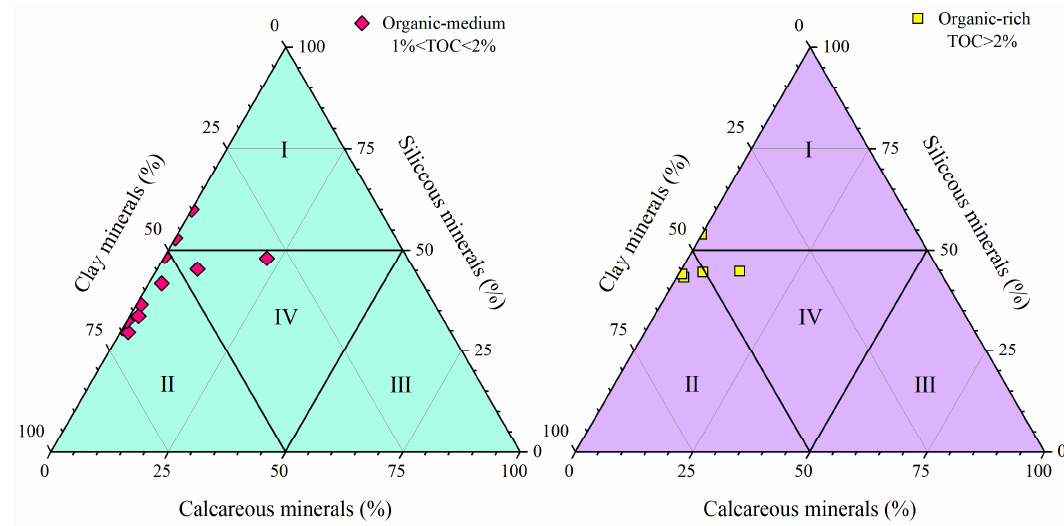
Figure 3. Lithofacies classification of the Shahezi shales in CFD (I: siliceous shale; II: argillaceous shale; III: calcareous shale; IV: mixed shale).